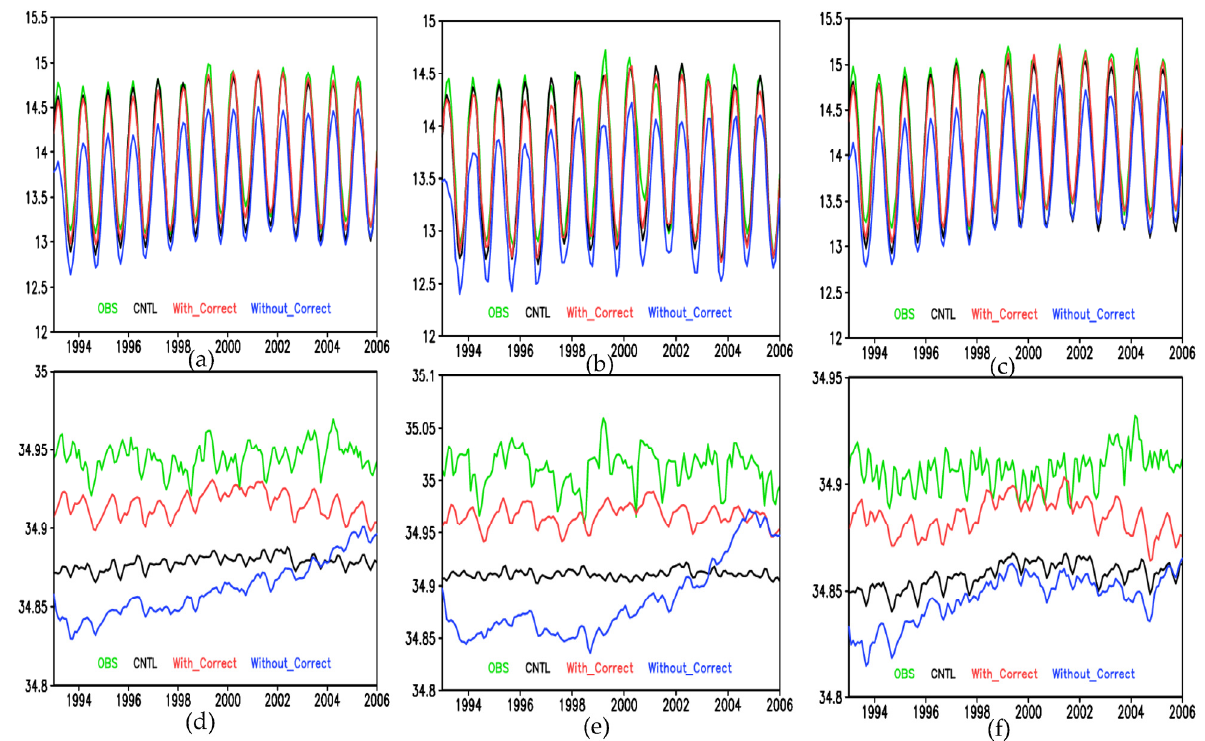
Figure 7. Time series of HC300 ( a – c ) and SC300 ( d – f ) averaged in different oceans from different experiments and observations. ( a , d ) Southern Indian and Southern Pacific oceans, ( b , e ) Southern Indian Ocean, ( c , f ) Southern Pacific Ocean.